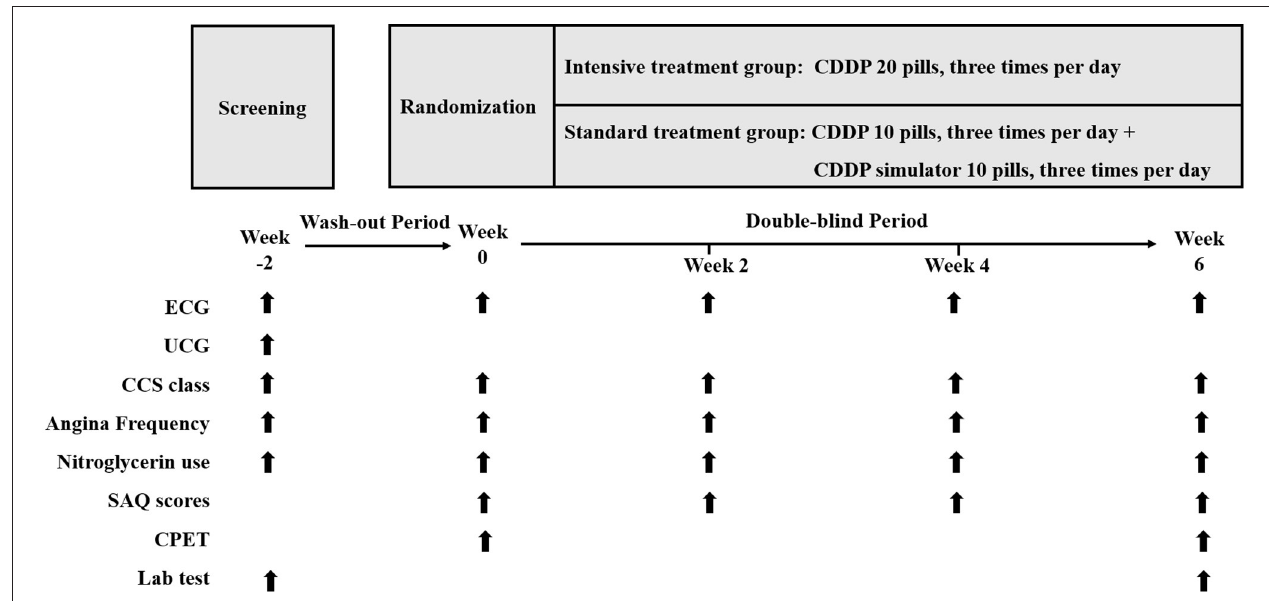
FIGURE 1 | Study design. CDDP, Compound Danshen Dripping Pills; ECG, electrocardiogram; UCG: echocardiography; CCS, Canadian Cardiovascular Society; SAQ, Seattle Angina Questionnaire; CPET, cardiopulmonary exercise testing.